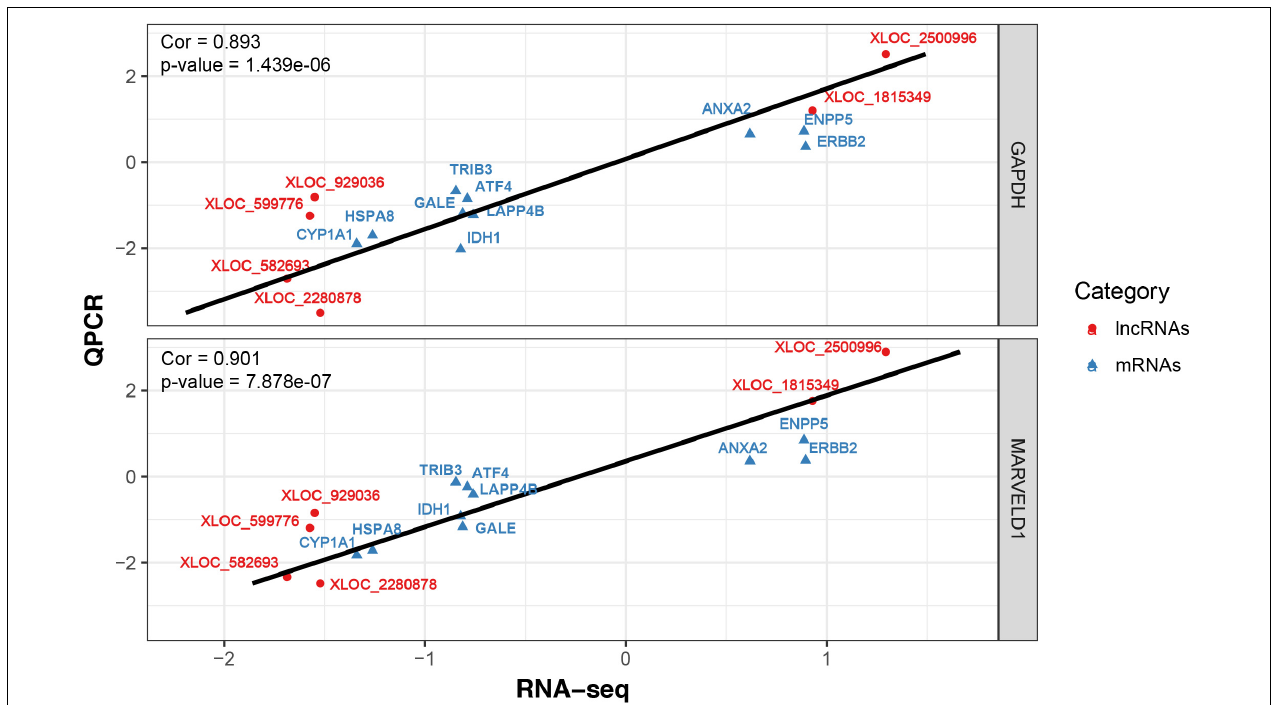
FIGURE 4 | Correlations of gene expression level of 10 differentially expressed genes and 6 lncRNAs between high and low milk protein percentage using RNA-Seq and qRT-PCR. The x - and y -axis show the log 2 (ratio of mRNA levels) measured by RNA-seq and qRT-PCR, respectively. GAPDH and MARVELD1 gene were used as housekeeping internal control. The red and blue dots represent the differentially expressed genes and lncRNAs,